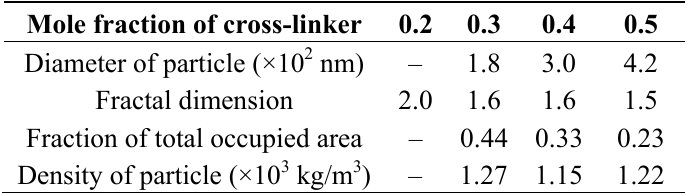
Table 1. Cross-linker concentration dependence of the structural parameters of the